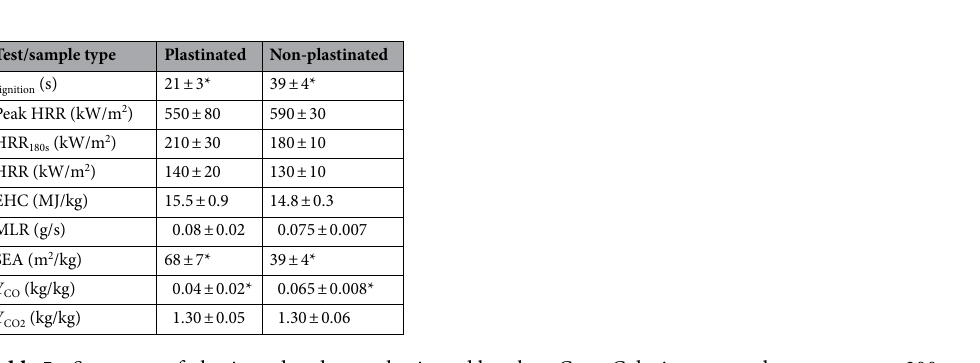
Table 5. Summary of plastinated and non-plastinated bamboo Cone Calorimeter results over t ignition + 300 s. *Significance level, P -value < 0.05 (One-way ANOVA).